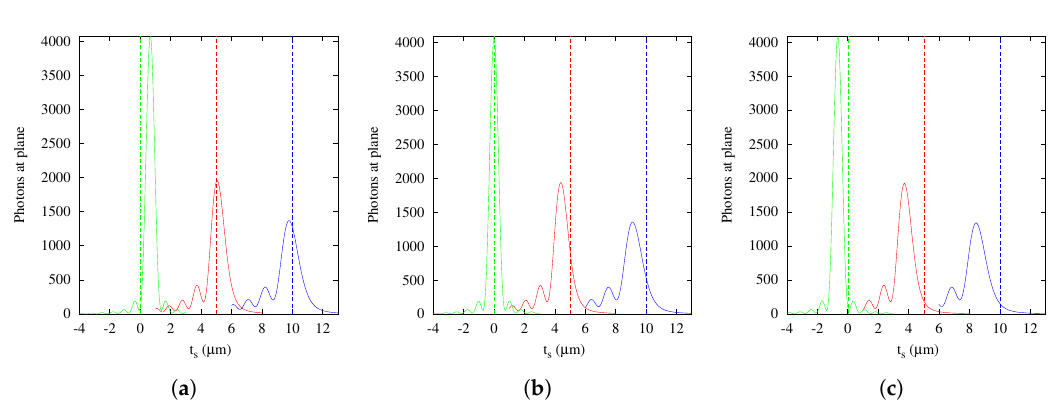
Figure 12. Intensity profiles along the optical axis of the Gibson and Lanni model. Green profiles, t s = 0 µ m; blue profiles, t s = 3 µ m; and red profiles, t s = 10 µ m. Center image, n oil in the design condition; left and right plots, n oil in the non-design conditions. ( a ) n oil = 1.510; ( b ) n oil = 1.515; ( c ) n oil =